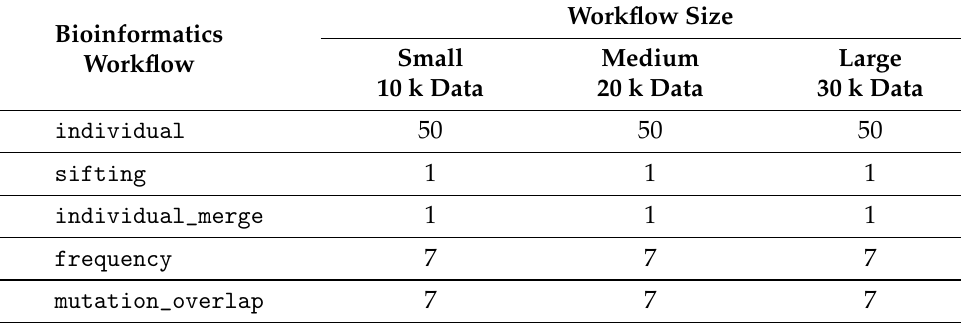
Table 3. Number of each job vs. Bioinformatics workflow